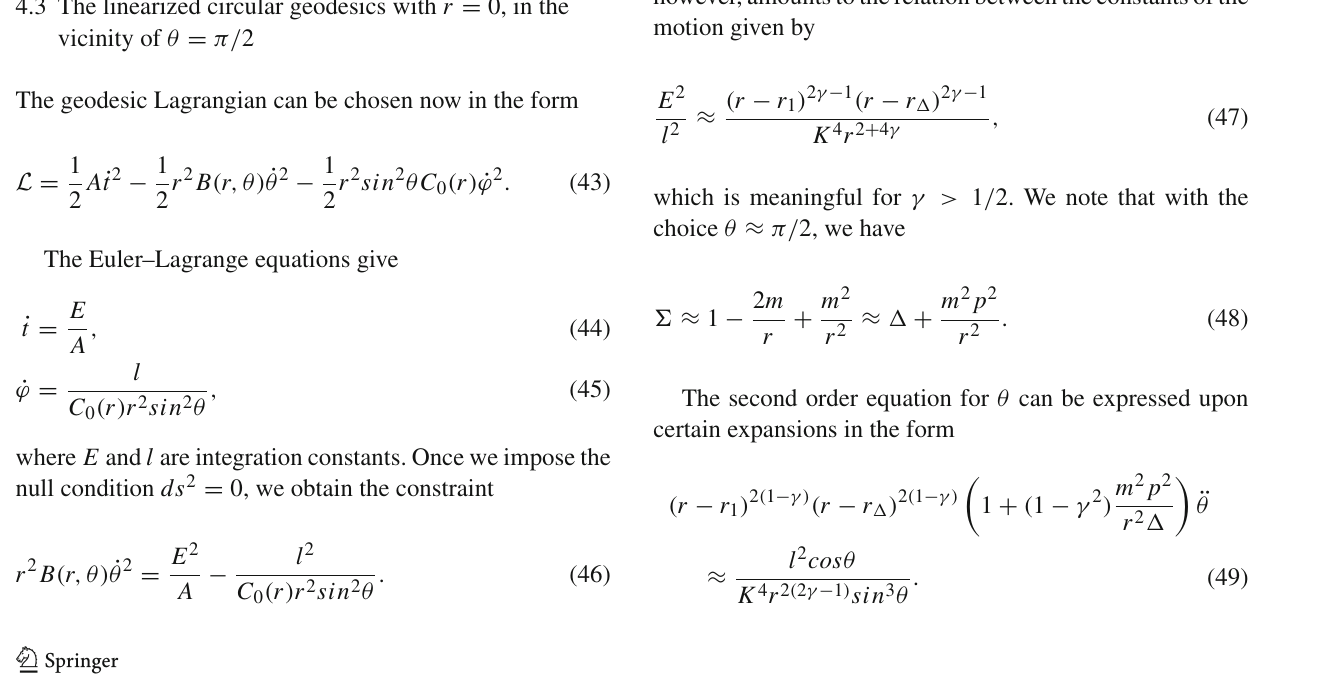
outer root r = r (cid:5) and we must avoid this. We remark that this conclusion is valid for θ (cid:8)= π/ 2 as well as for θ = π/